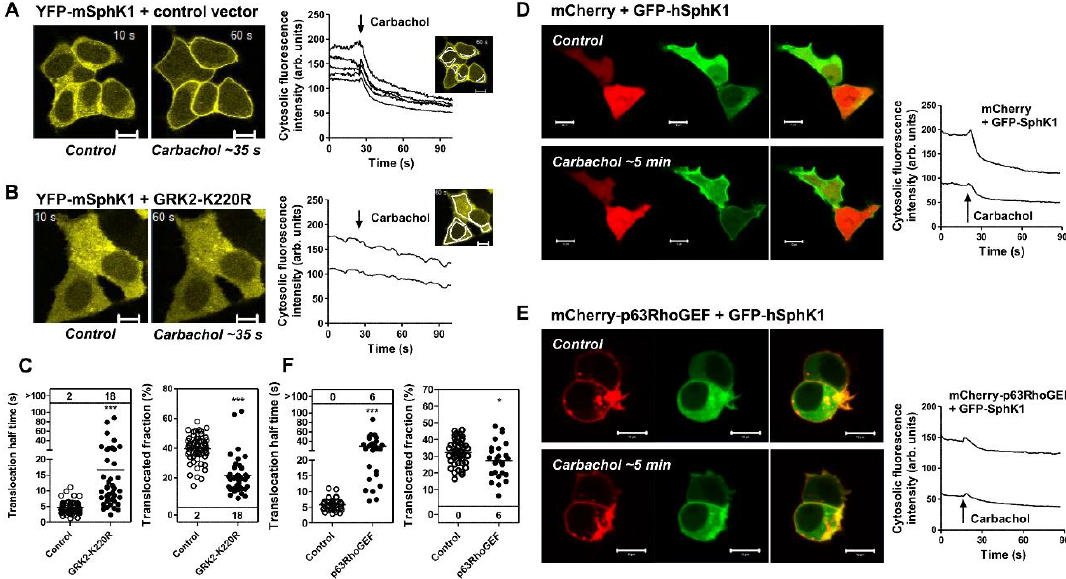
Figure 1. Influence of catalytically inactive GRK2 and p63RhoGEF on M 3 receptor-induced SphK1 translocation. HEK-293cellsstablyexpressingtheM 3 muscarinicacetylcholinereceptorweretransfected as indicated and translocation of SphK1 was monitored by live cell imaging with a confocal laser scanning microscope. ( A – C ) Cells were transfected with YFP-mSphK1 and either catalytically inactive GRK2 (GRK2-K220R) or control vector. Time series were acquired with ~3 images / s and 100 µ M carbachol was added after ~25 s. Images were taken from representative time series at 10 and 60 s, thus showing localization of YFP-mSphK1 before and ~35 s after stimulation with carbachol, respectively. The line graphs show the corresponding time courses of cytosolic fluorescence intensity, measured in the indicated cytosolic regions. ( C ) The SphK1 translocation half-times were measured by fitting exponential curves to the translocation-induced decay in cytosolic fluorescence intensity. Each dot represents a single cell. Translocation half-times > 100 depict the number of cells which did not respond. Note: *** p < 0.0001 in t -tests with Welch’s correction for unequal variances. ( D – F ) Cells were transfected with GFP-hSphK1 (green) and either mCherry or mCherry-p63RhoGEF (red). Representative images were taken at high spatial resolution immediately before and after the acquisition of time series, during which only GFP fluorescence was monitored with 1 image / s. The line graphs showing time courses of cytosolic fluorescence intensity correspond to the cells shown in the images. Carbachol was added at the indicated time points. ( F ) SphK1 translocation half-time was measured as described in (C). Note: * p < 0.05, *** p < 0.0001 in t -tests with Welch’s correction for unequal variances. Micrometer bars, 10 µ